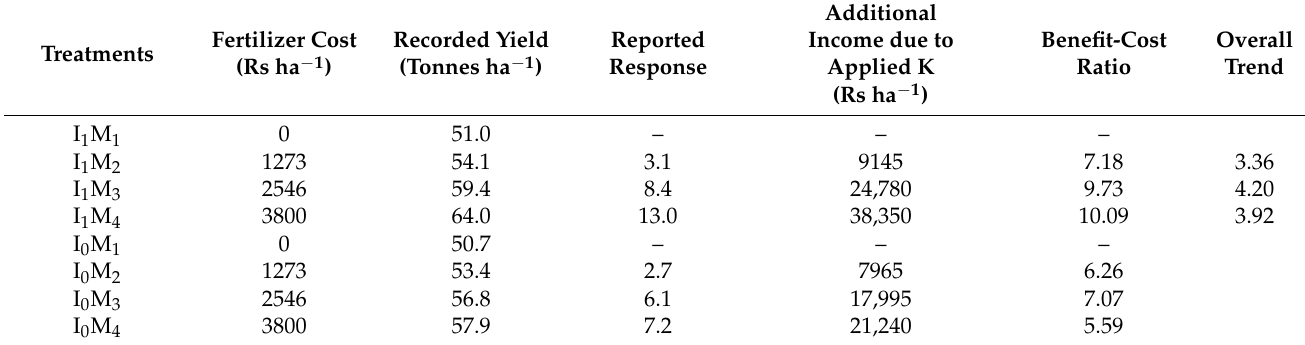
Table 9. Benefit-to-cost ratio of the ratoon crop under irrigation and potassium